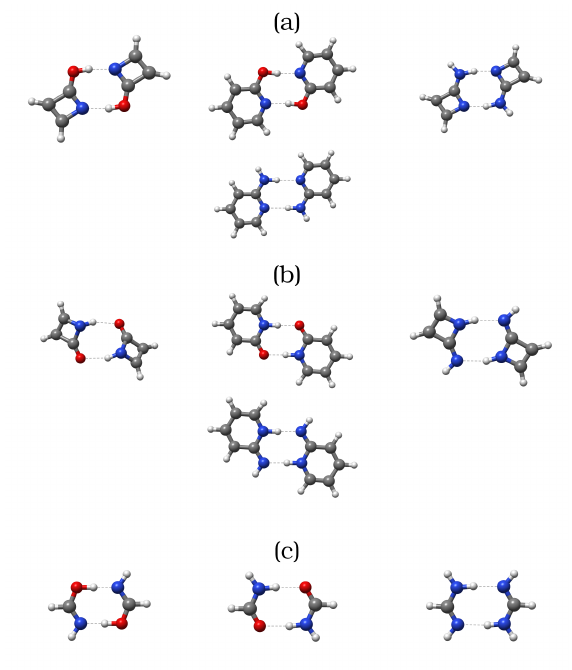
Figure 2. Systems examined throughout this investigation. ( a ) Dimers with the hydrogen bond acceptor contained within the ring (ACR): azet-2-ol (AZH), 2- hydroxypyridine (2HP), azet-2-amine (AZA) and 2-aminopyridine (2AP). ( b ) Dimers with the hydrogen bond donor contained within the ring (DCR): azet-2(1 H )-one (AZH), pyridin-2(1 H )-one (2HP), azet-2-amine (AZA) and pyridin-2(1 H ) imine (2AP). ( c ) Representation of the ACR and DCR dimers of formamide (NCO) and formamidine (NCN), used as reference. In NCN, the ACR and DCR tautomers are